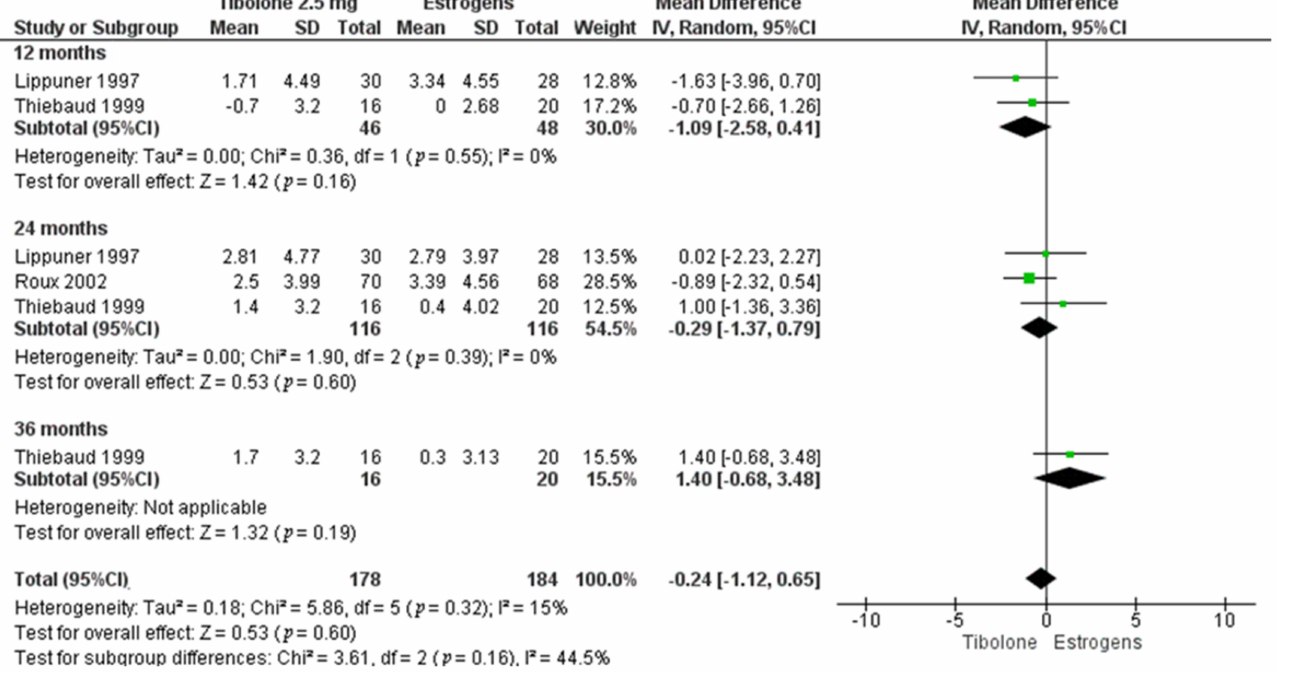
Figure 3. Forest plot of the meta-analysis of mean difference in BMD percentage change from baseline femoral neck through time (12, 24 and 36 months). Hologic densitometer. Tibolone 2.5 mg versus